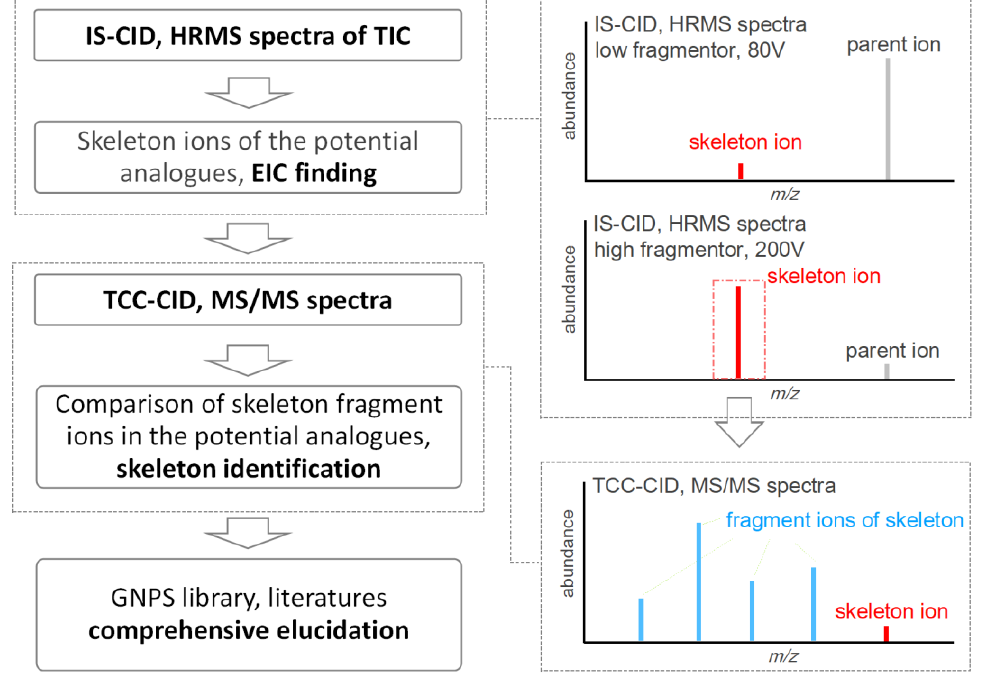
Figure 1. An improved strategy combining IS-CID with TCC-CID to screen analogues with the same skeleton.